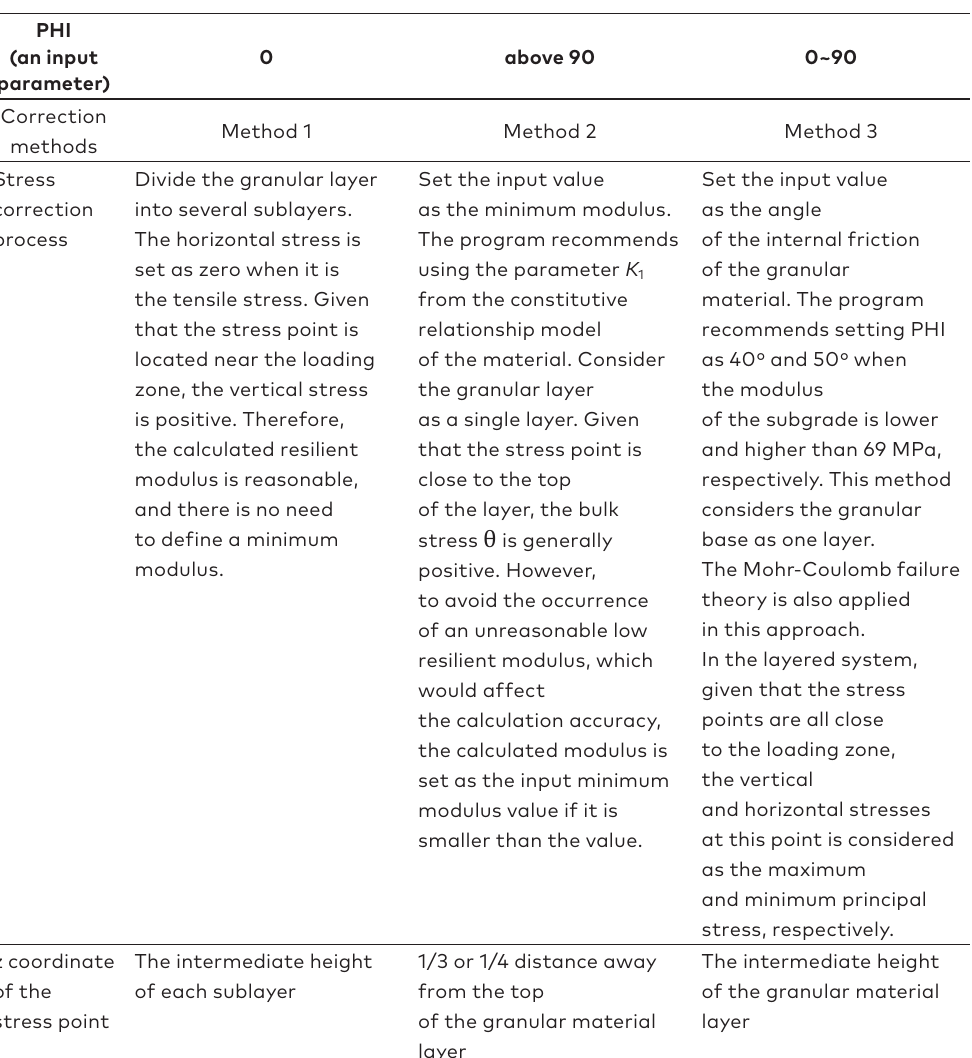
Table 2. Stress correction methods for granular